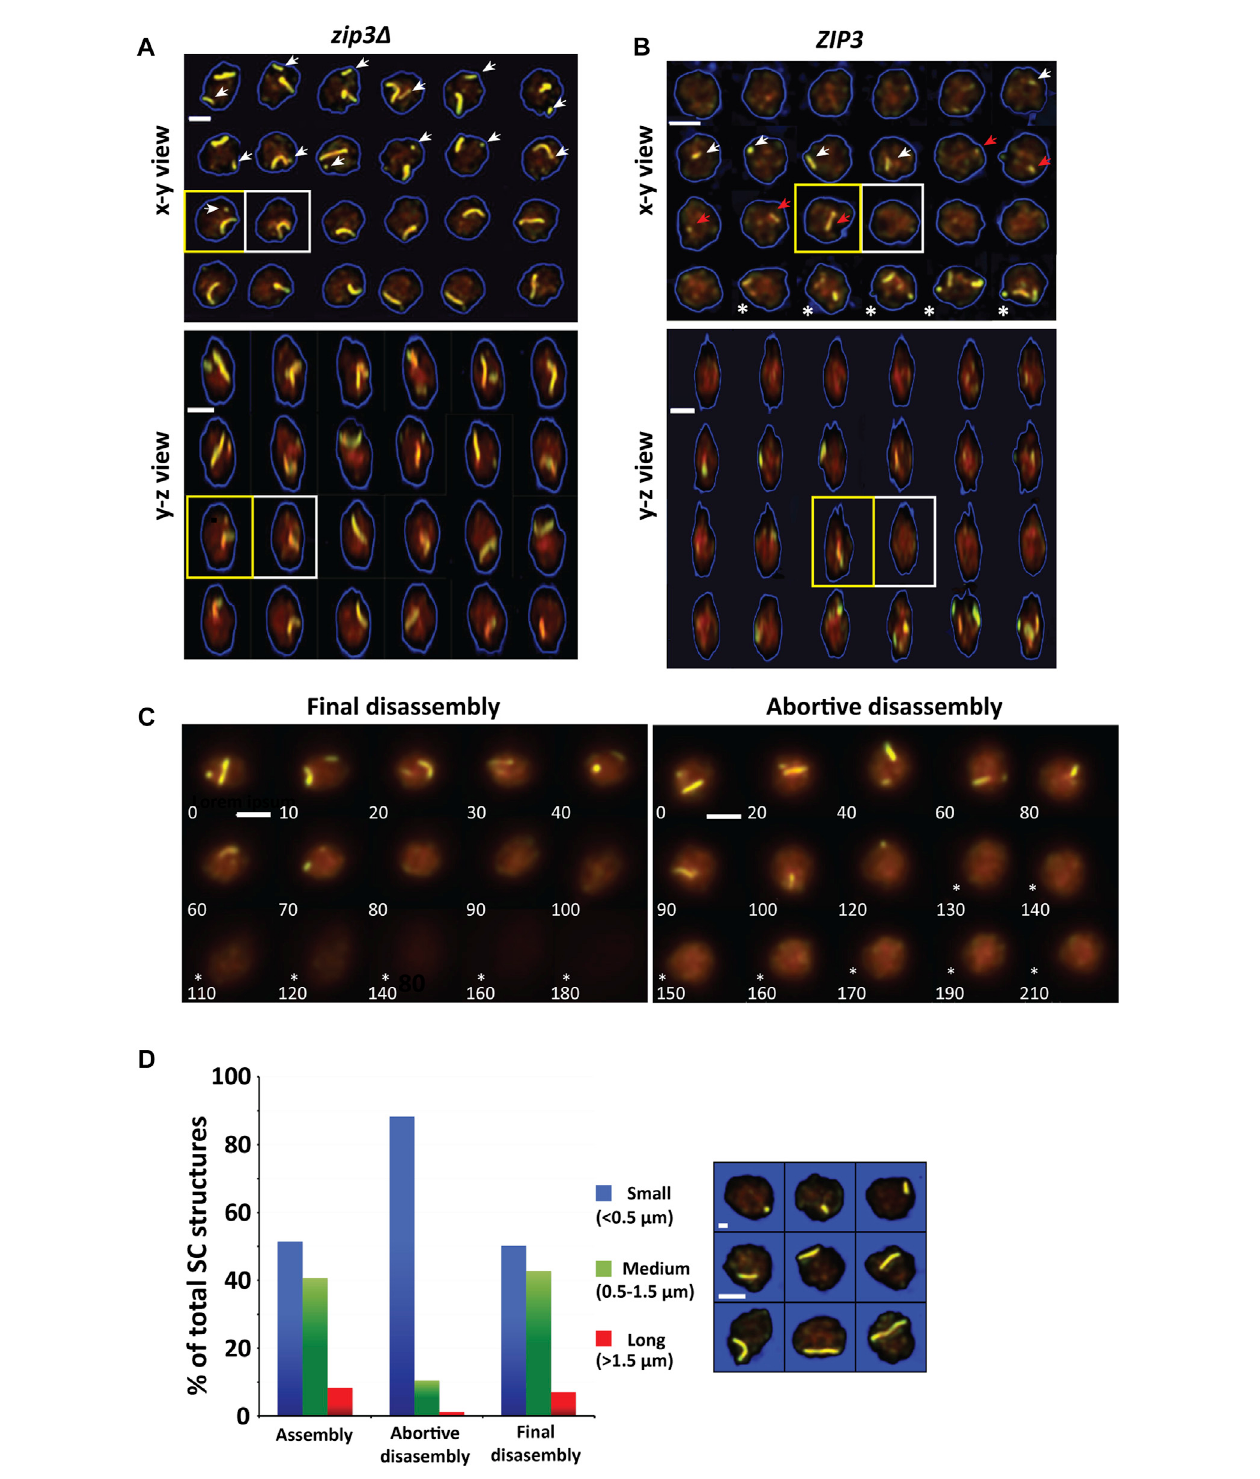
Abortive synapsis disassembly. (A) A time-series of 2D triple-overlay projections from 3D image stacks of a single zip3 Δ nucleus at 5-minute intervals showing abortive disassembly for the smaller (white arrow) of the two chromosomes. The yellow square outlines the last time frame in which the smaller chromosomeislastobserved.Thewhitesquareshowstimeframeinwhichsmallerchromosomeisnolongerobserved.Belowisthesametime-seriesinay-z view. Scale bar — 2 µm. (B) A time-series of 2D triple-overlay projections from 3D image stacks of a single ZIP3 nucleus at 20-minute intervals showing abortive disassembly chromosomes. The white arrow indicates a SC that formed and then disassembled. The red arrow represents either the same SC as indicatedbythewhitearrowthatdidnotfullydisassembleoranSCthatnewlyformed.Theyellowsquareoutlineswhenthechromosomeislastobserved.The white square outlines time when chromosome has disassembled. Several timepoints later after a period in which there is no SCs, new SCs form in the timeframes indicated by (*). Below is the same time-series in a y-z view. Scale bar — 2 µm. (C) Abortive synapsis disassembly is distinguishable from fi nal disassemblybythehighlevelsofZip1thatremains(rightpanel,timepoints130 – 210indicatedby*)ascomparedto fi naldisassemblyoftheSCwhenZip1levels decrease (left panel, timepoints 110 – 180 indicated by *). Left panel – fi nal disassembly. Right panel – abortive disassembly (D) Distribution of SC sizes divided into small ( < 0.5 µm), medium (0.5 – 1.5 µm) and large ( > 1.5 µm) for SC assembly ( n = 230), abortive disassembly ( n = 171) and fi nal disassembly ( n = 530). Images show example SCs belonging to each size